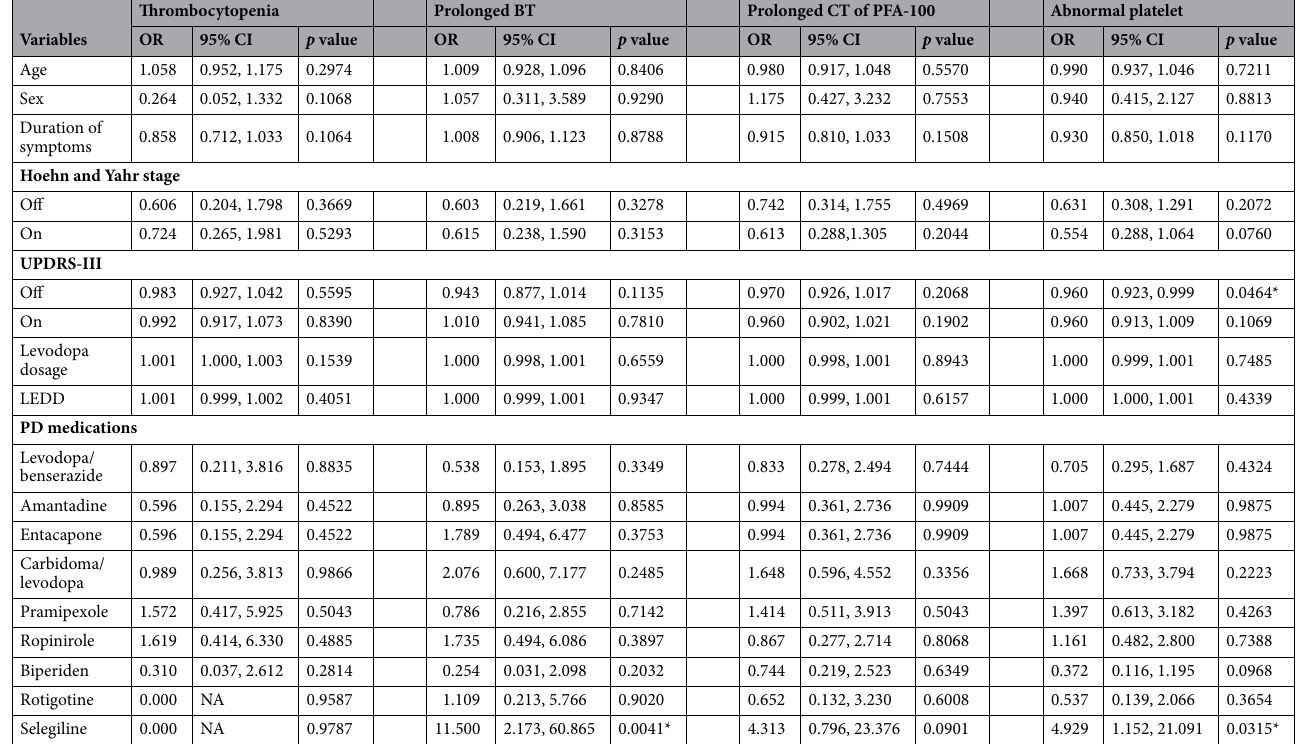
Table 3. Univariate analysis of the factors affecting platelet count and function in PD patients. PD, Parkinson’s disease; BT, bleeding time; CT, closure time; PFA-100, Platelet Function Analyzer-100; OR, odds ratio; CI, confidence interval; UPDRS, Unified Parkinson’s Disease Rating Scale; LEDD, levodopa equivalent daily dose. *Statistically significant.